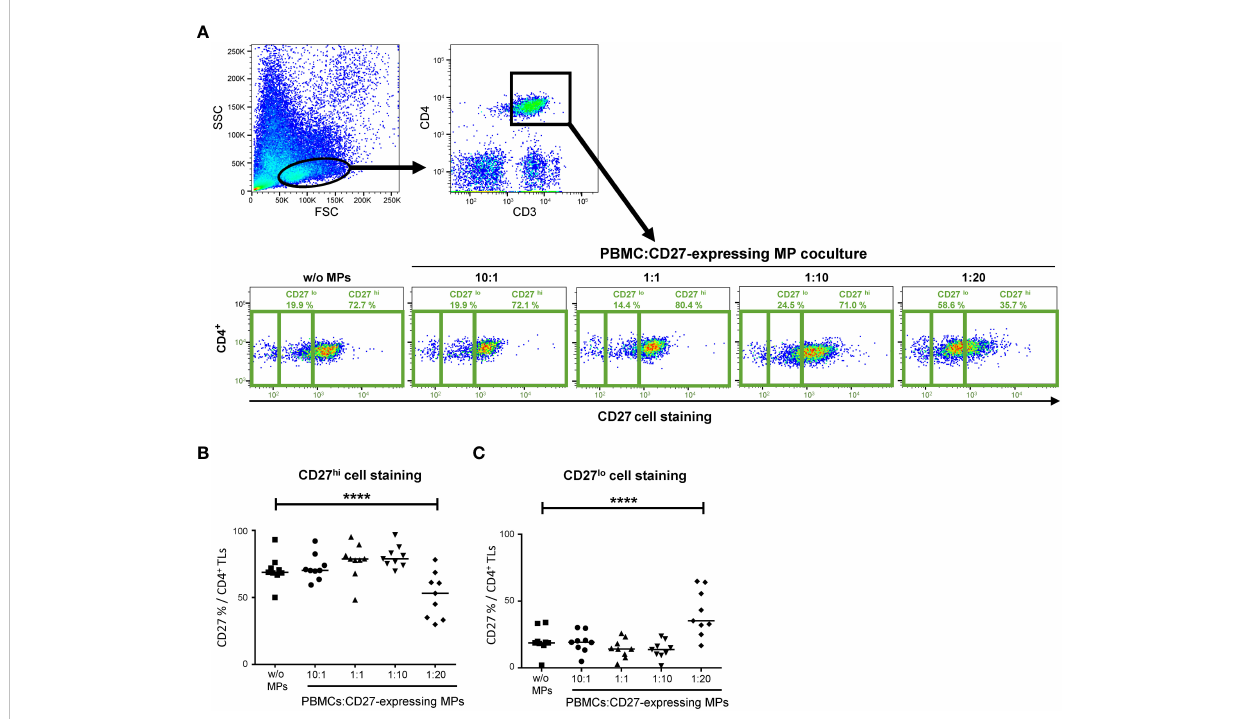
FIGURE 6 Assays of competition between CD27 + MPs and PBMCs for CD27 staining. (A) Example of the gating used for assessing the CD27 expression of CD4 + T cells cocultured (PBMCs were stained with anti-CD4 and anti-CD3 antibodies; CD4 + TLs were de fi ned as having a CD3 + CD4 + phenotype), at various ratios, with MPs from one HD. PBMCs were incubated with 1) different amounts of MP preparations containing known numbers of CD27- expressing MPs, to obtain different ratios of cells to CD27-expressing MPs and 2) an anti-CD27 antibody (labeled with BV510). Phenotyping was performed on CD4 + TLs from 9 HDs in 6 experiments. (B) Percentage of CD4 + LTs with high levels of CD27 staining (MFI >8 x 10 2 ). (C) Percentage of CD4 + LTs with low levels of CD27 staining (0.5 x 10 2 <MFI<8 x 10 2 ). The horizontal bar indicates the median. The P values were obtained in ANOVA and Kruskal-Wallis post hoc tests: **** P <